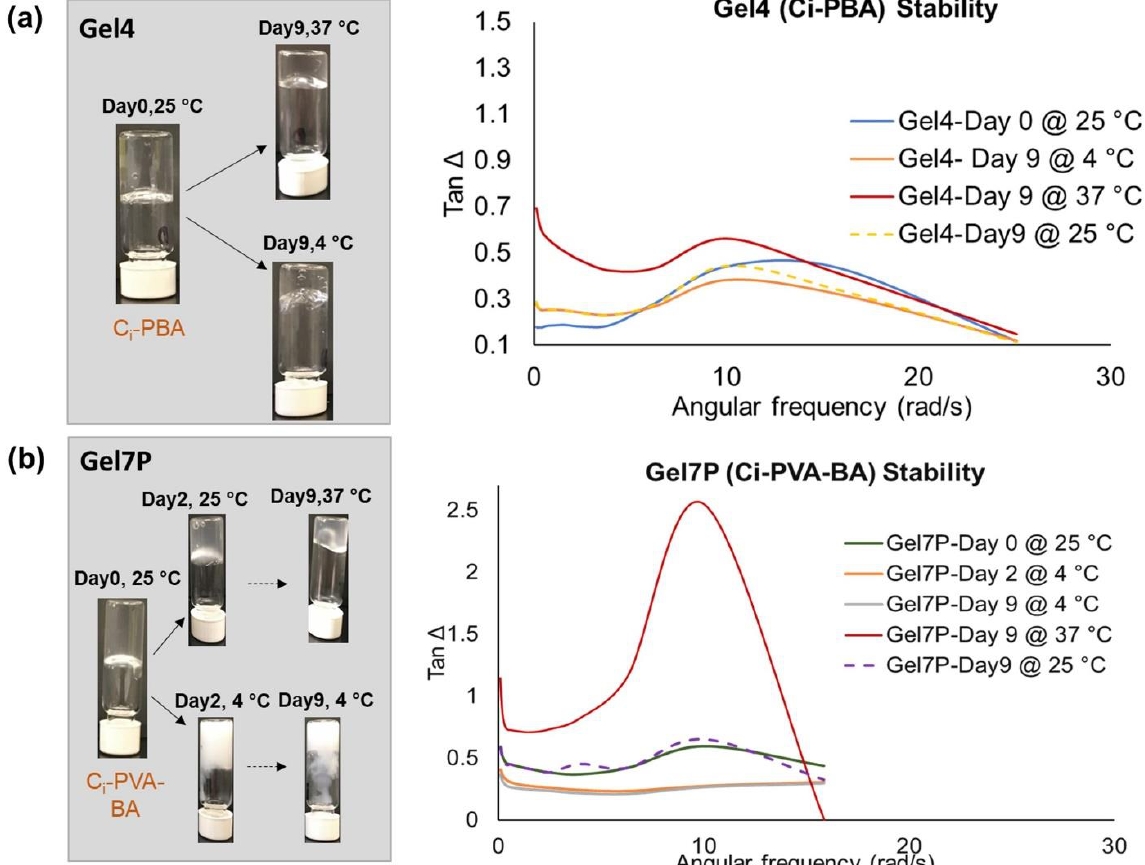
Figure 9. Tan Δ values and physical changes observed for: ( a ) C i -PBA gel (Gel 4) and ( b ) C i -PVA-BA gel (Gel 7P) stored at 25 °C, 4 °C, and 37 °C for up to 9 days.